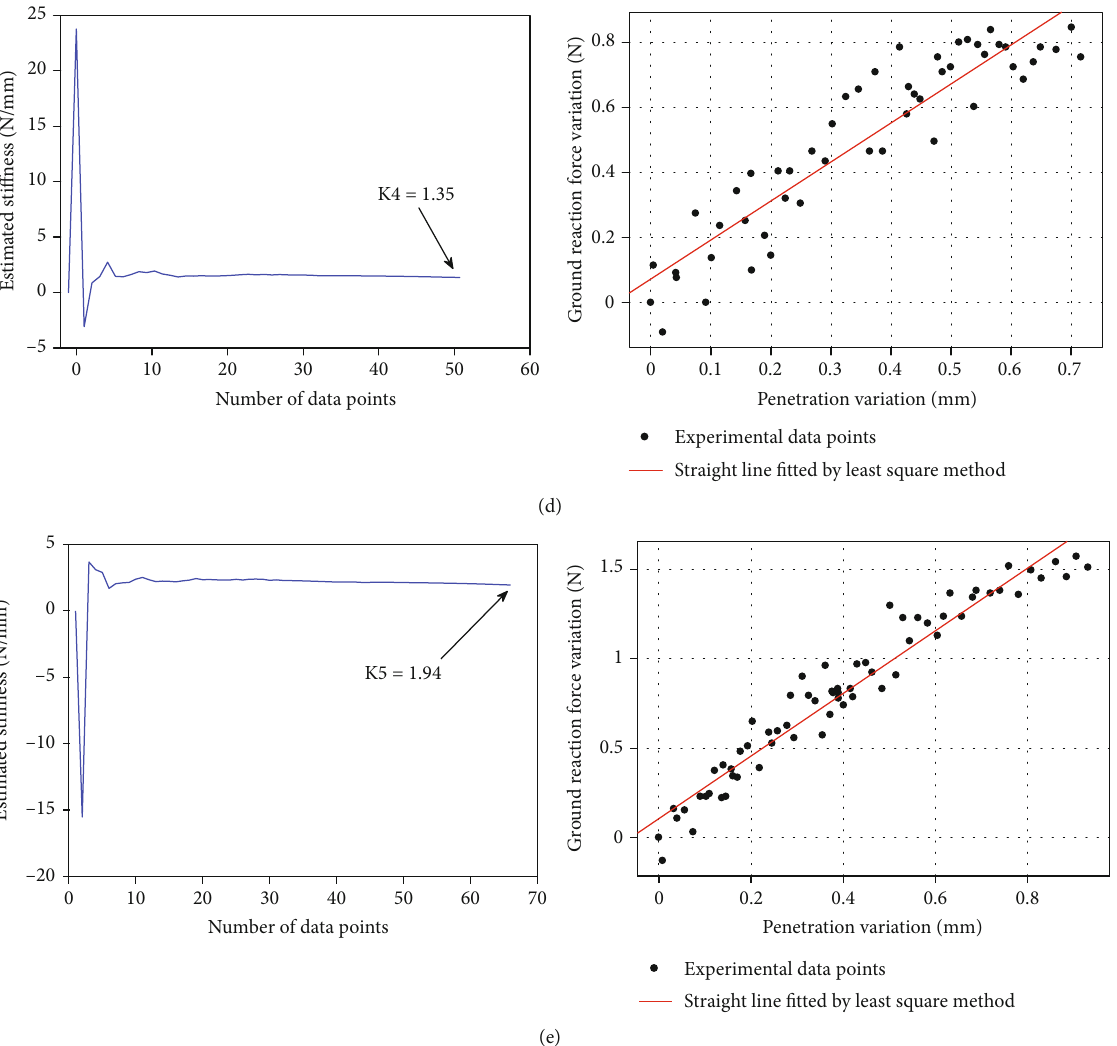
Figure 17: The recursive change process of sti ff ness and the fi tting straight line. (a) Medium hard rubber. (b) High durometer rubber. (c) Low hardness sponge. (d) Medium hardness sponge. (e) High hardness